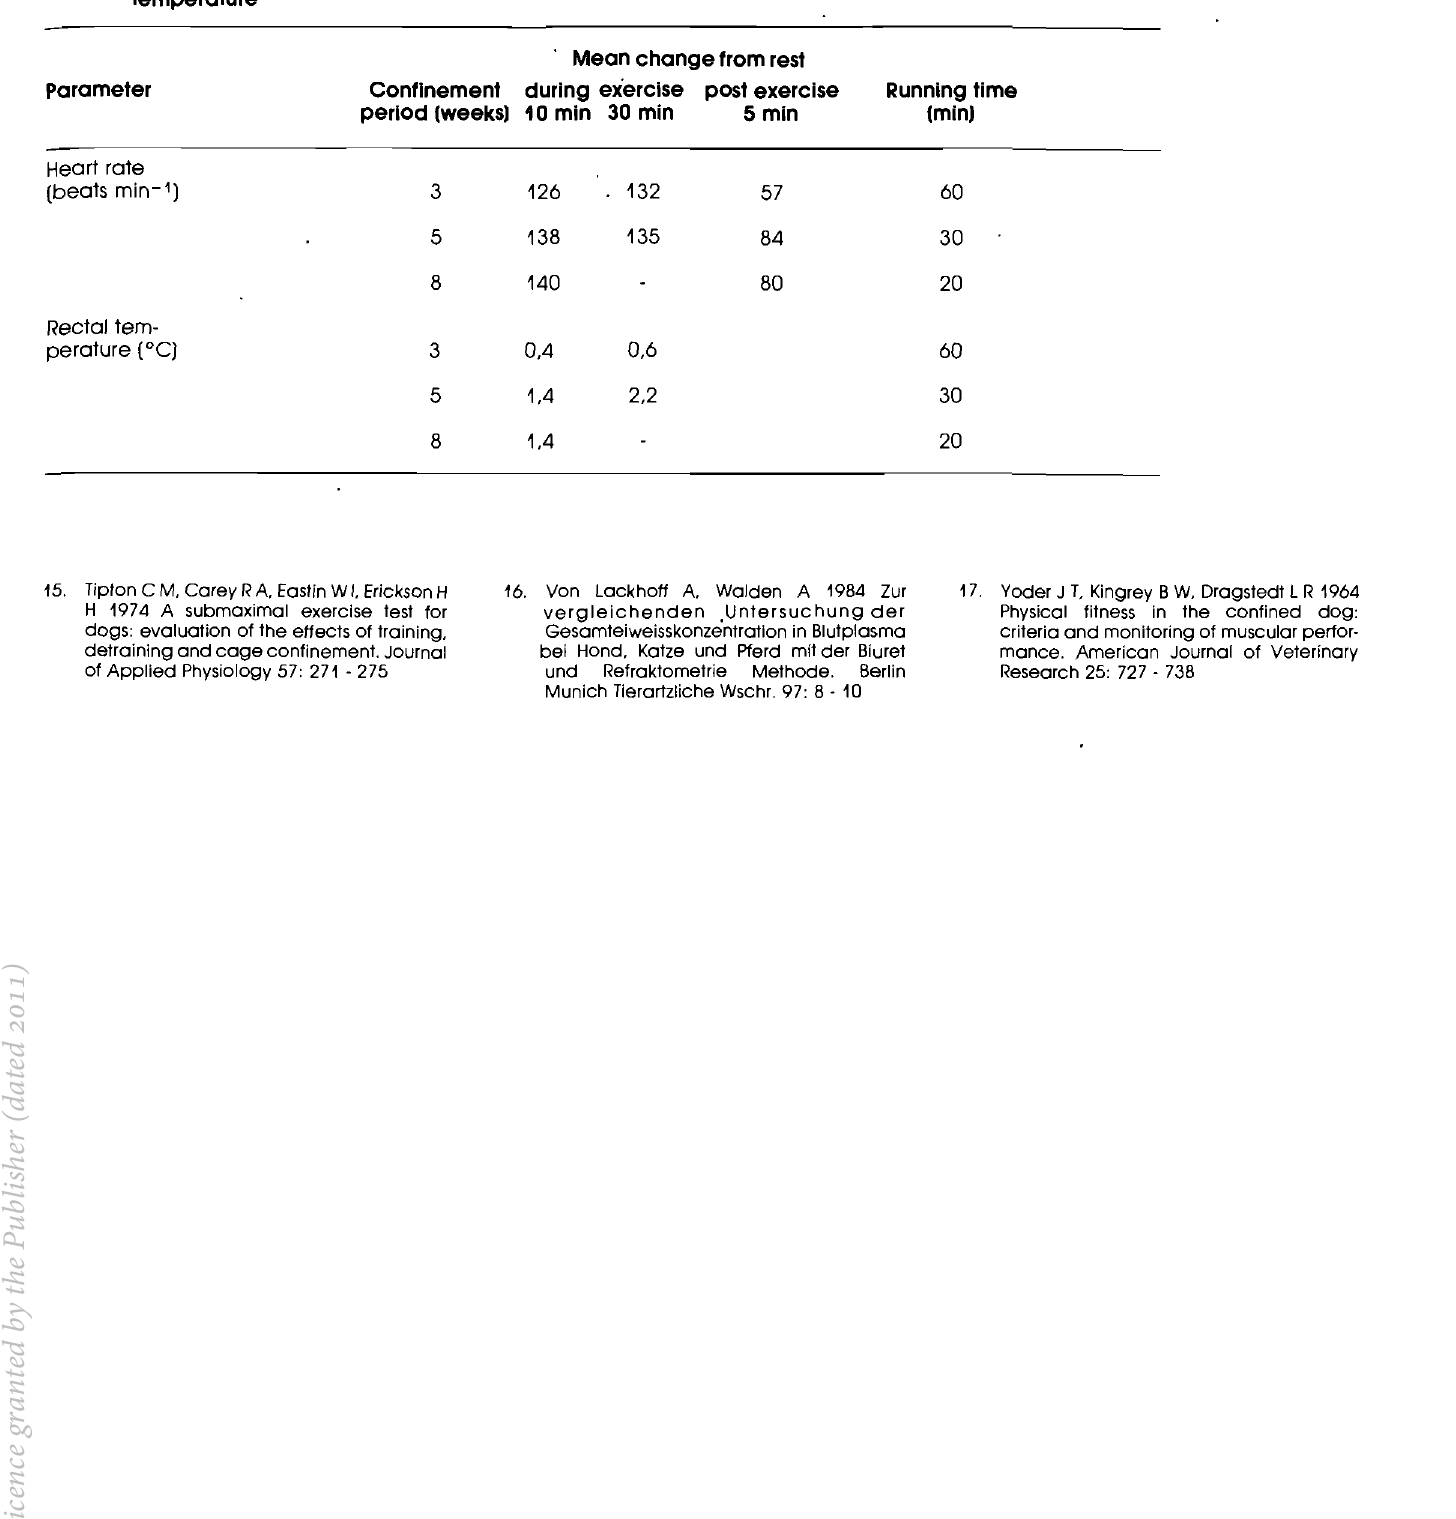
Table 8: Mean ch'ange from resting value at Weeks 3,5 and 8 of detraining (Phase 5) for heart rate and rectal temperature ' , Mean change from rest